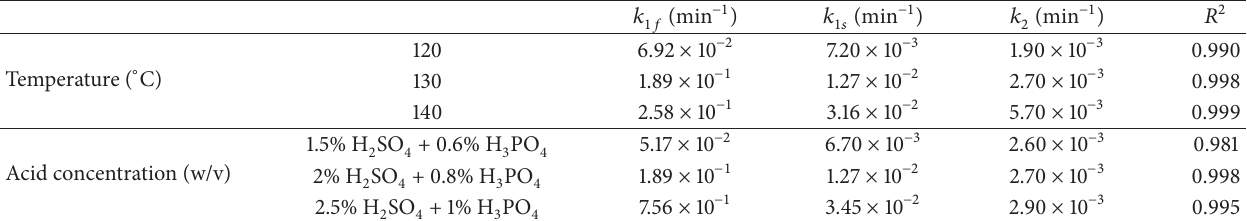
Table 1: Estimated kinetic parameters of biphasic model at different temperatures and acid concentrations.